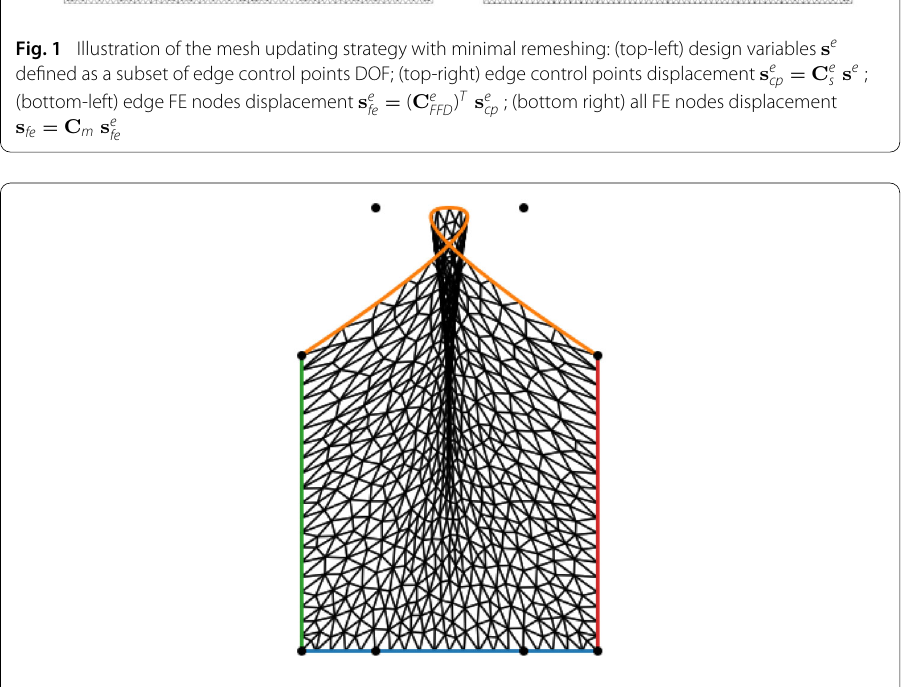
Fig. 2 Non permissible geometry, due to the loop made by the upper edge